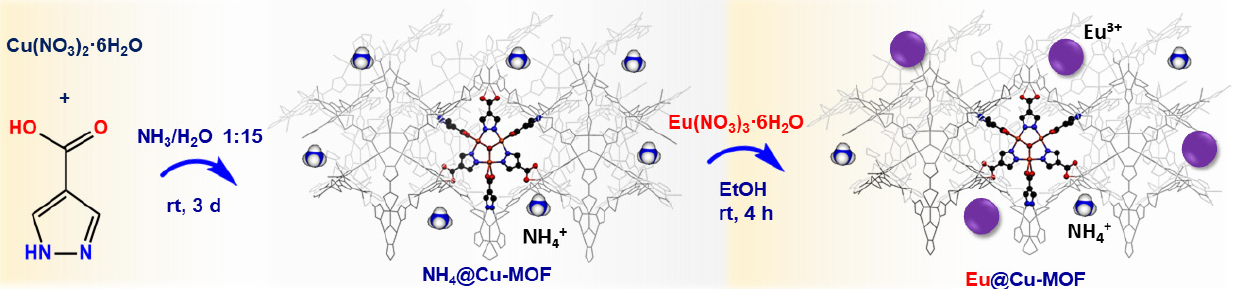
Figure 1. Synthesis scheme of Eu@Cu-MOF.